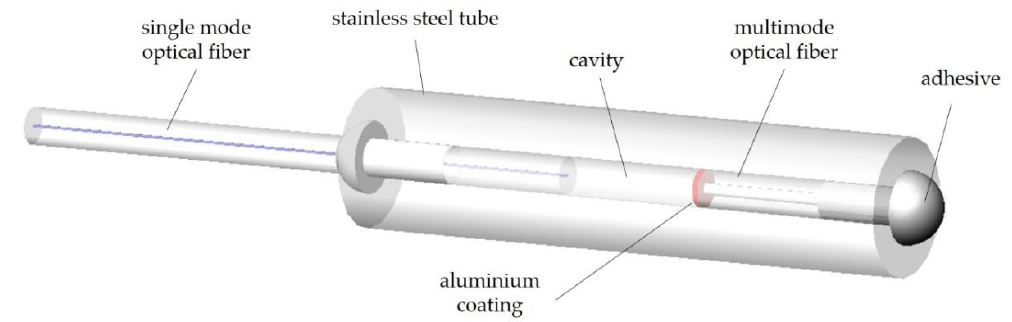
Figure 5. Schematic drawing of the temperature sensor proposed by Rao and Jackson. A stainless steel tube was made transparent to allow component visualization. (Adapted from [127].)